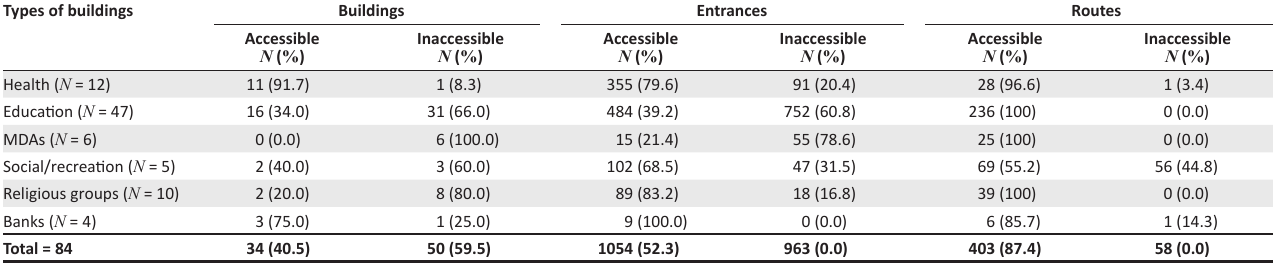
TABLE 2: Distribution of buildings, entrances, and routes accessible to wheelchair